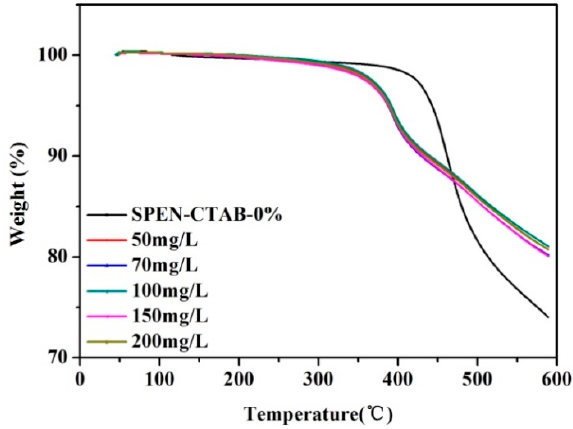
Figure 8. TGA curves of the SPEN-CTAB-0% before and after adsorption.